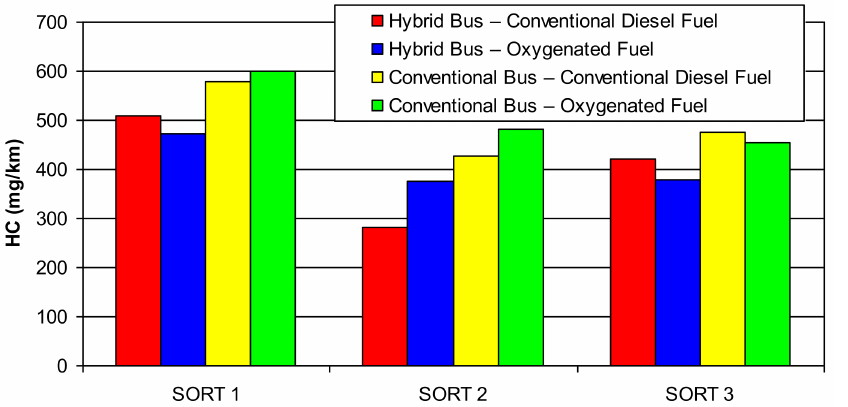
Figure 11. Comparison of HC emissions of serial hybrid and conventional city buses running on conventional and oxygenated diesel fuel, over the SORT cycles.